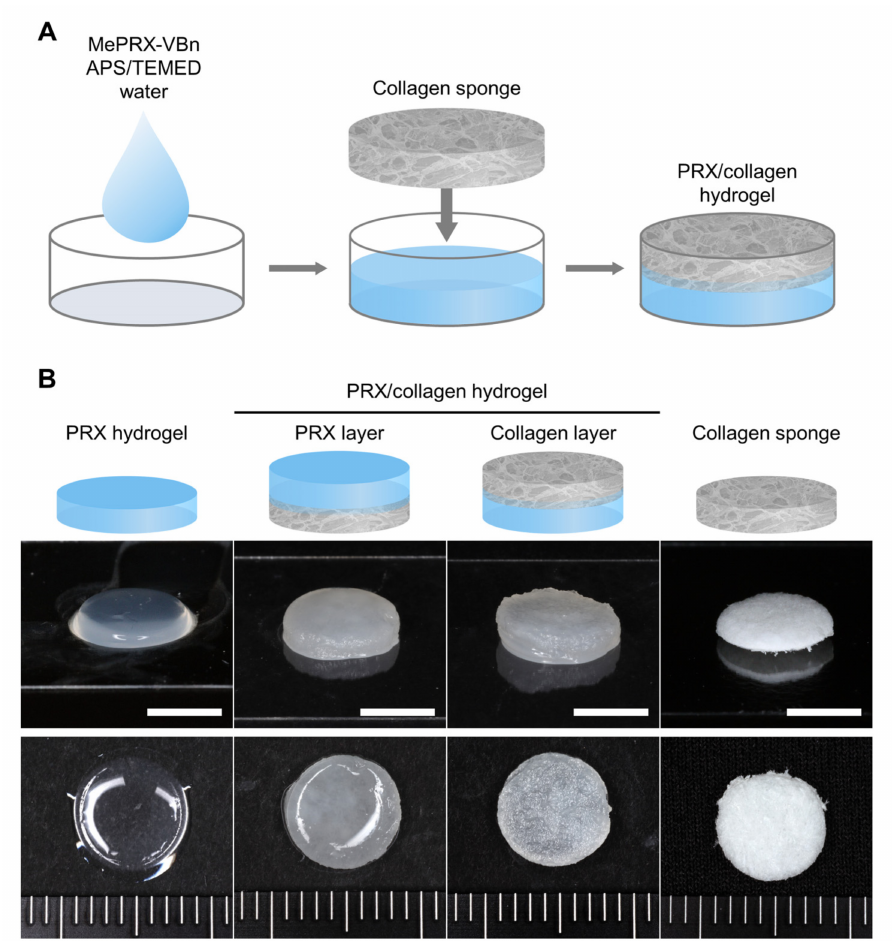
Figure 3. ( A ) Schematic of the fabrication procedure for hydrogels. ( B ) Photographs of polyrotaxane (PRX) hydrogels, PRX hydrogel side (PRX layer), and collagen sponge side (collagen layer) of PRX/collagen hydrogels and collagen sponges (scale bar: 5